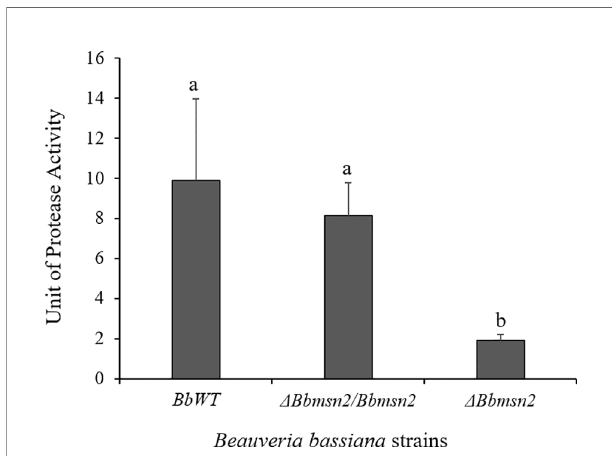
FIGURE 5 | Protease activity on the cuticle of Rhipicephalus microplus treated by an immersion in a conidial suspension of Beauveria bassiana strains: BbWT, D Bbmsn2/Bbmsn2 or D Bbmsn2 , and incubated for 120 h at 26 ± 1°C and RH ≥ 90%. Bars with different letters, i.e. “ a ” and “ b ” , indicate signi fi cant difference ( P < 0.05). Standard errors are based on three independent